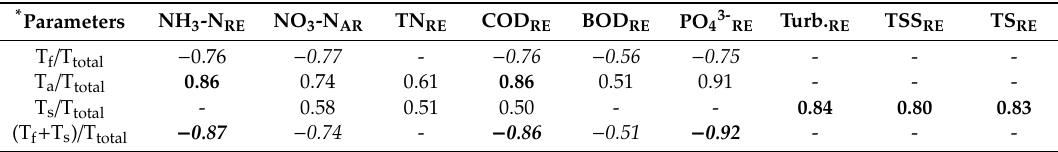
Table3. Correlationmatrixfortheremovale ffi cienciesofwastewaterqualityparametersandoperational parameters of the SBR